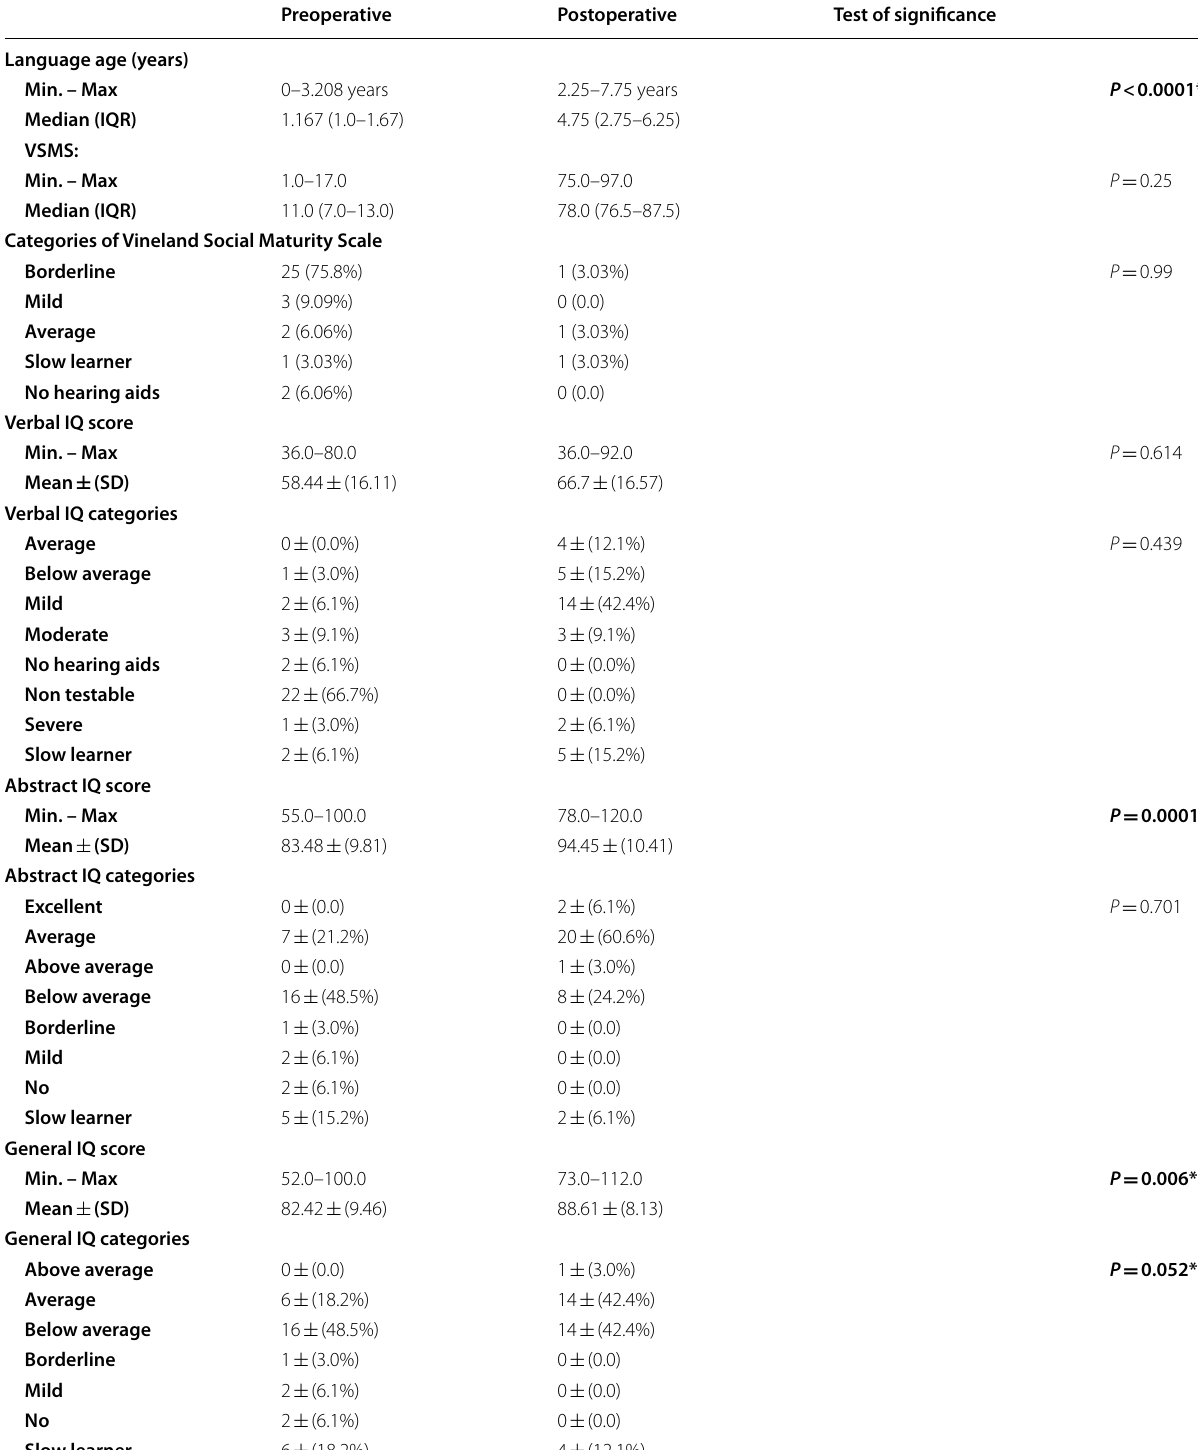
Table 3 Comparison of median of language age and intellectual abilities of the studied population preoperative and postoperative Preoperative Postoperative Test of